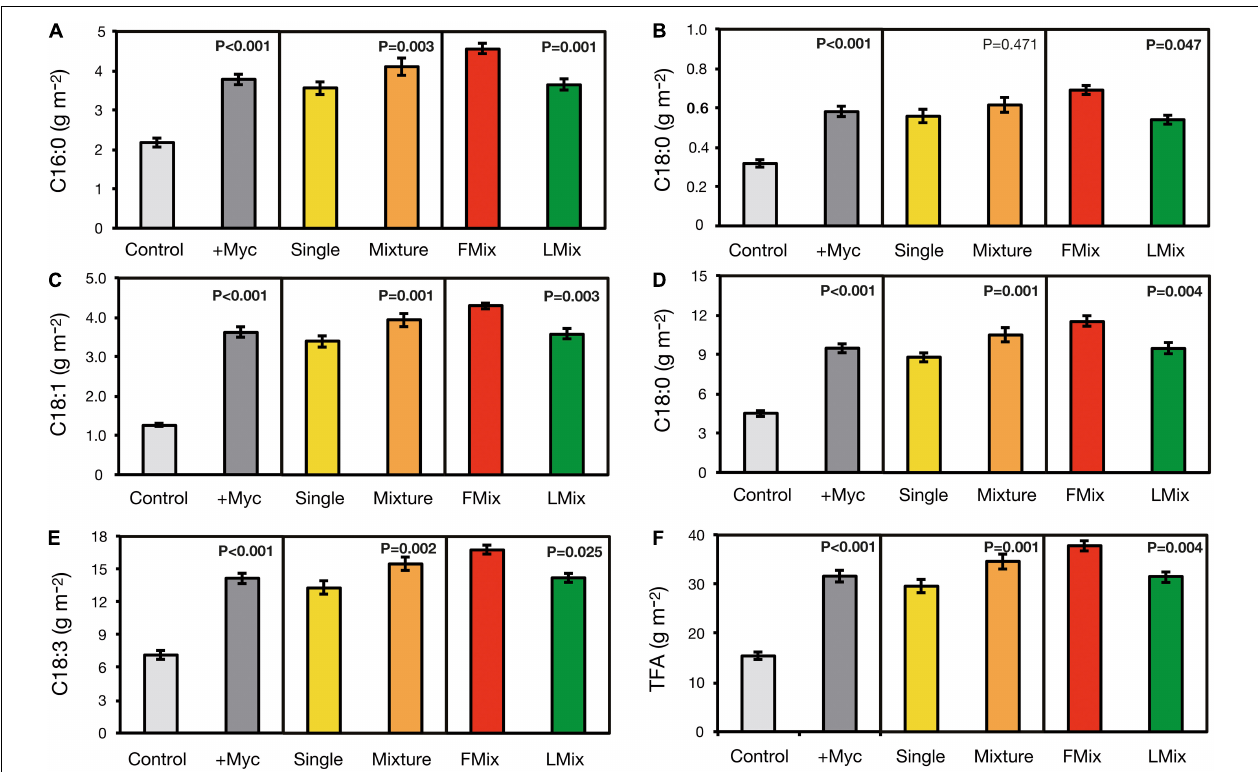
FIGURE 3 | The single (A–E) and total fatty acid (F) content of alfalfa ( Medicago sativa L.) accumulated over cuts and years as affected by AM fungal inoculation. Results of orthogonal contrasts used for discriminating the differences between means: inoculated (+ Myc) vs. control, single arbuscular mycorrhizal (AM) fungal isolates vs. mixture inoculants (Single vs. Mixture), and foreign vs. local AM fungal mixtures (FMix vs. LMix) [Inoculants: F. mosseae BEG12, F. mosseae AZ225C, R. irregularis BEG141, foreign mixture-FMix (BEG12, AZ225C, and BEG141), local mixture-LMix of 14 AM fungal species belonging to five families, and mock-inoculated control]. Data are mean ± SE (three plot replicates per inoculum